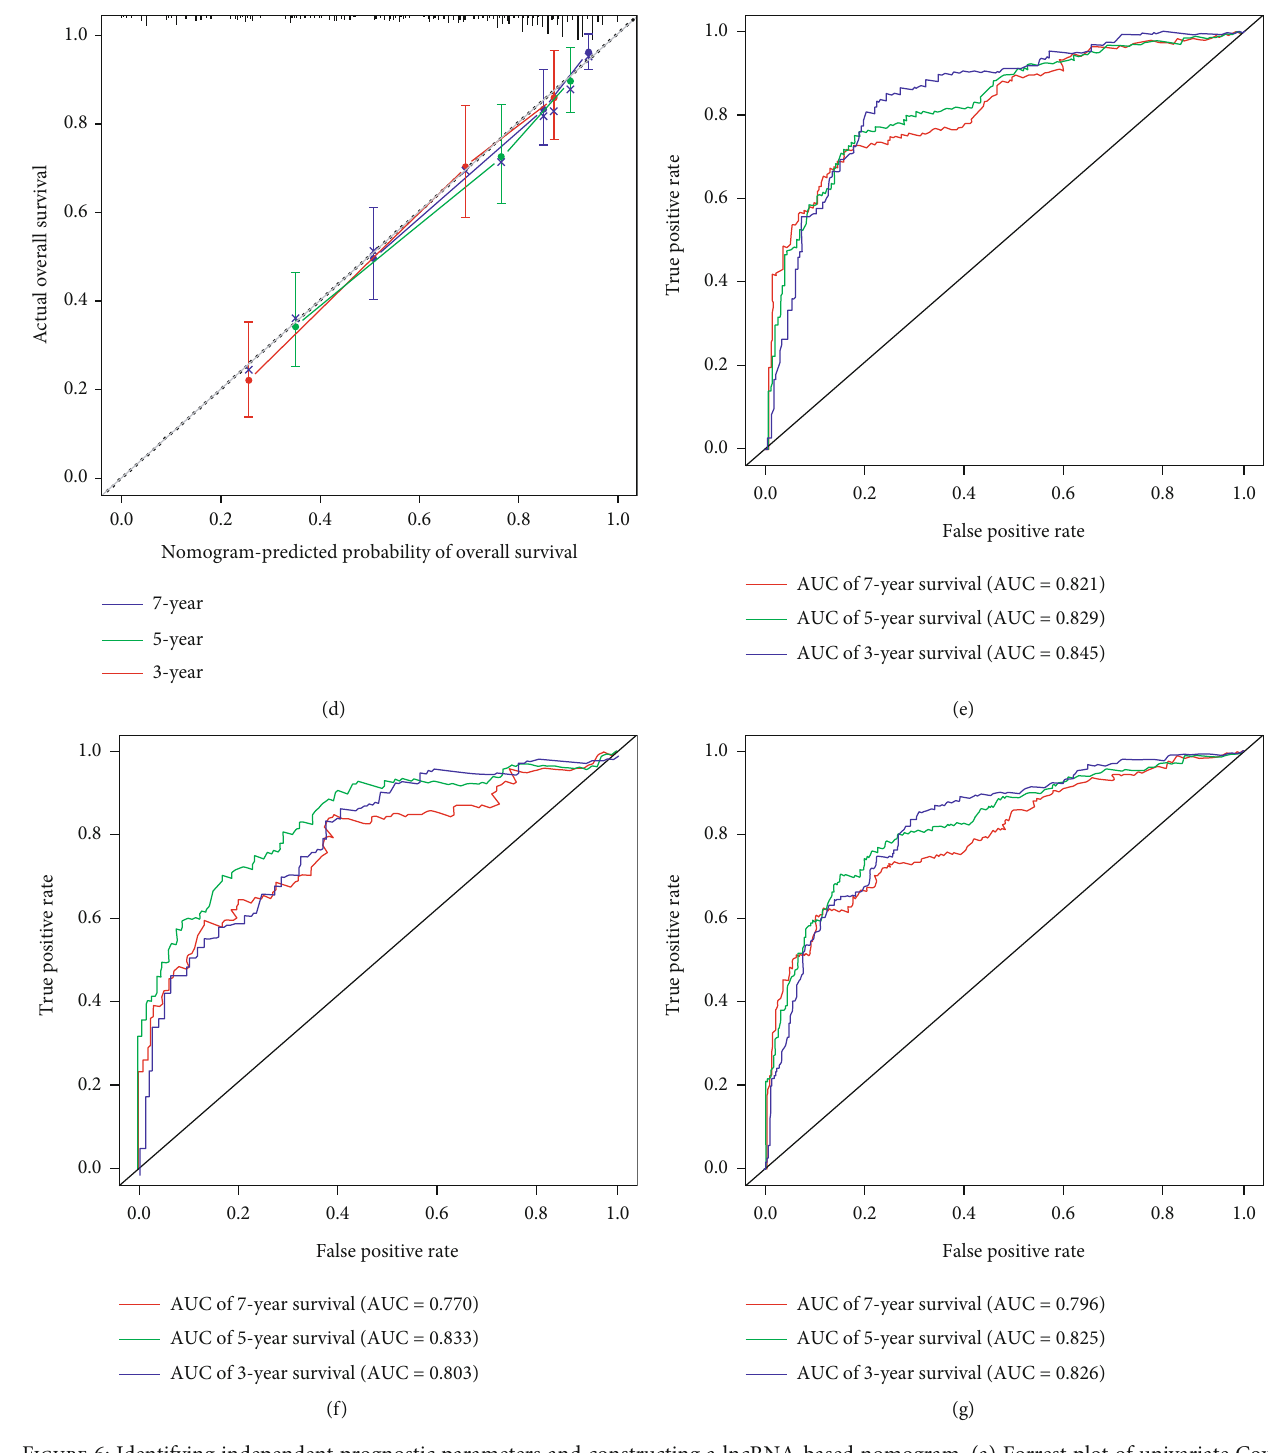
Figure 6: Identifying independent prognostic parameters and constructing a lncRNA-based nomogram. (a) Forrest plot of univariate Cox regression analysis in ccRCC. (b) Forrest plot of multivariate Cox regression analysis in ccRCC. (c) A lncRNA-based nomogram integrating AJCC-stage, Fuhrman-grade, age, pharmaceutical, and risk score to predict 3-, 5-, and 7-year OS of ccRCC patients. (d) The calibration plot of the nomogram for predicting 3-, 5- and 7-year OS of ccRCC patients. E-G, Time-dependent ROC curves of the nomogram for 3-, 5-, and 7-year OS prediction in the training set, the testing set, and the whole set. AJCC: American Joint Committee on Cancer; OS: overall survival; ccRCC: clear cell renal cell carcinoma; ROC: receiver operating